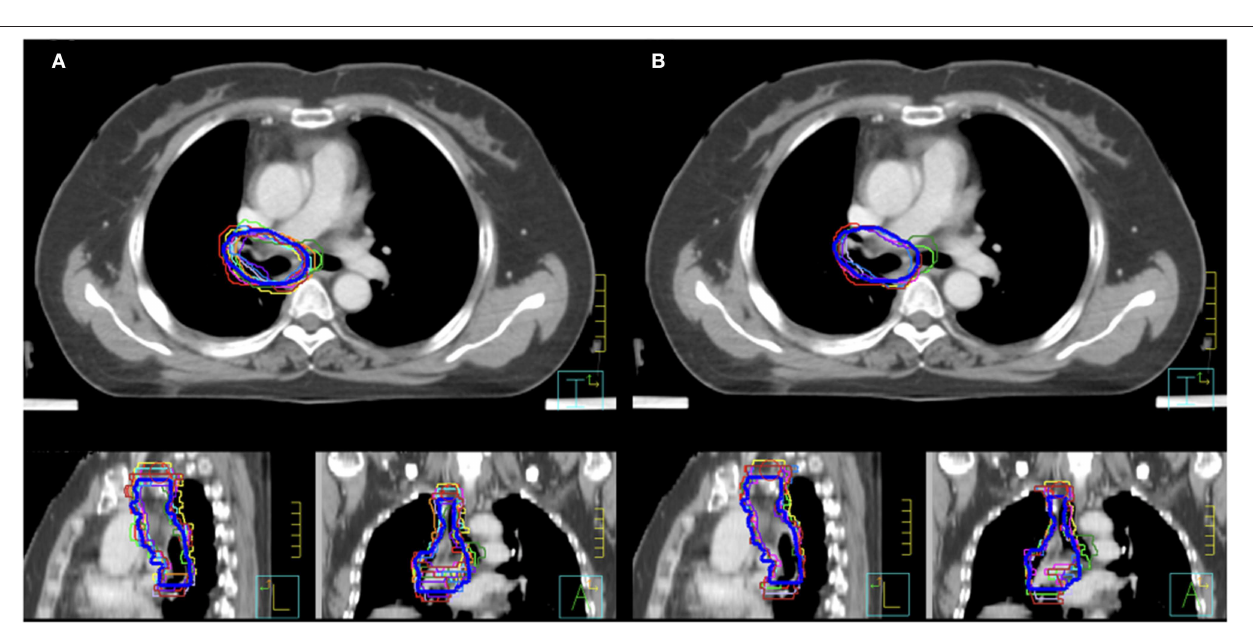
FIGURE 1 | (A) Scatter plots of the volume measurements of the senior radiation oncologists’ contours for each patient with a DLC (black triangle) and MC (yellow square) and (B) summary of the junior radiation oncologists’ contours for each patient with a DLAC (blue boxes) and MC (yellow boxes), with whiskers from the 5–95th percentiles. DLC, deep learning contour; DLAC, deep learning-assisted contour; MC, manual contour.